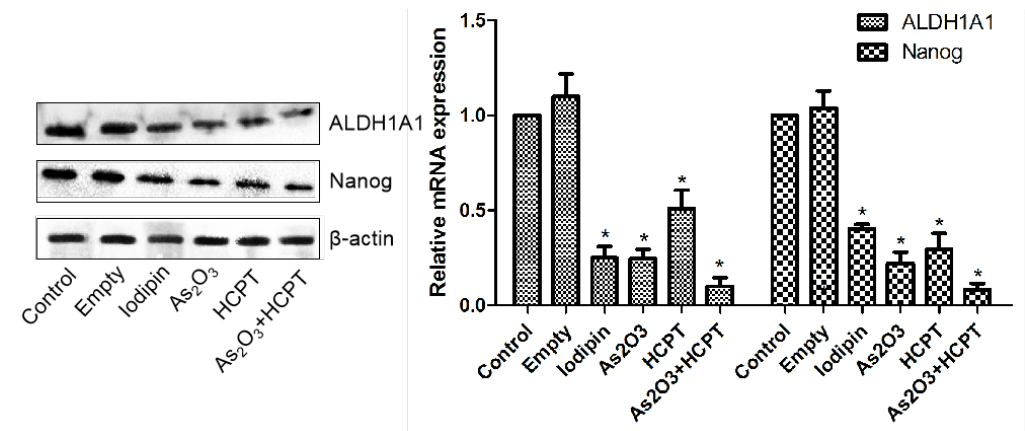
Fig. 2. ALDH1A1 and Nanog expression levels in different groups (* P <0.05 vs. Control).